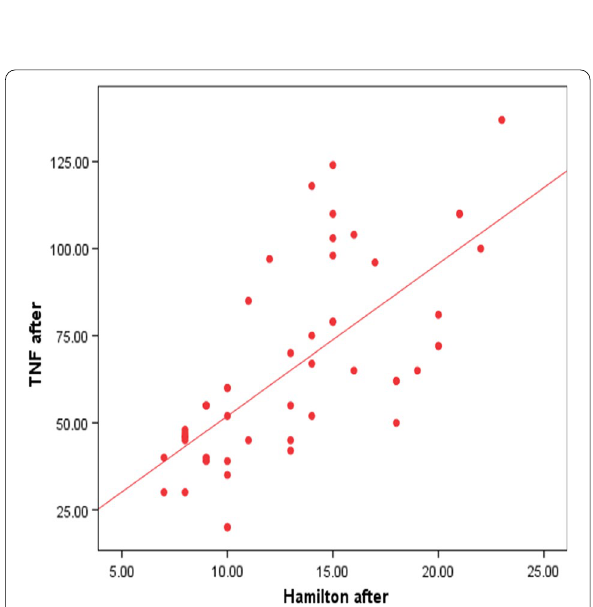
Fig. 1 Positive correlation between TNF‑α and